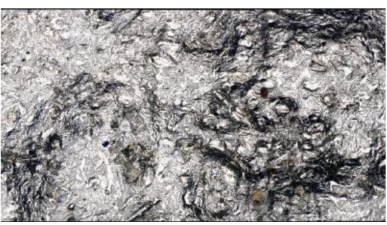
Figure 16. Surface quality DA30, magnification 500 ×